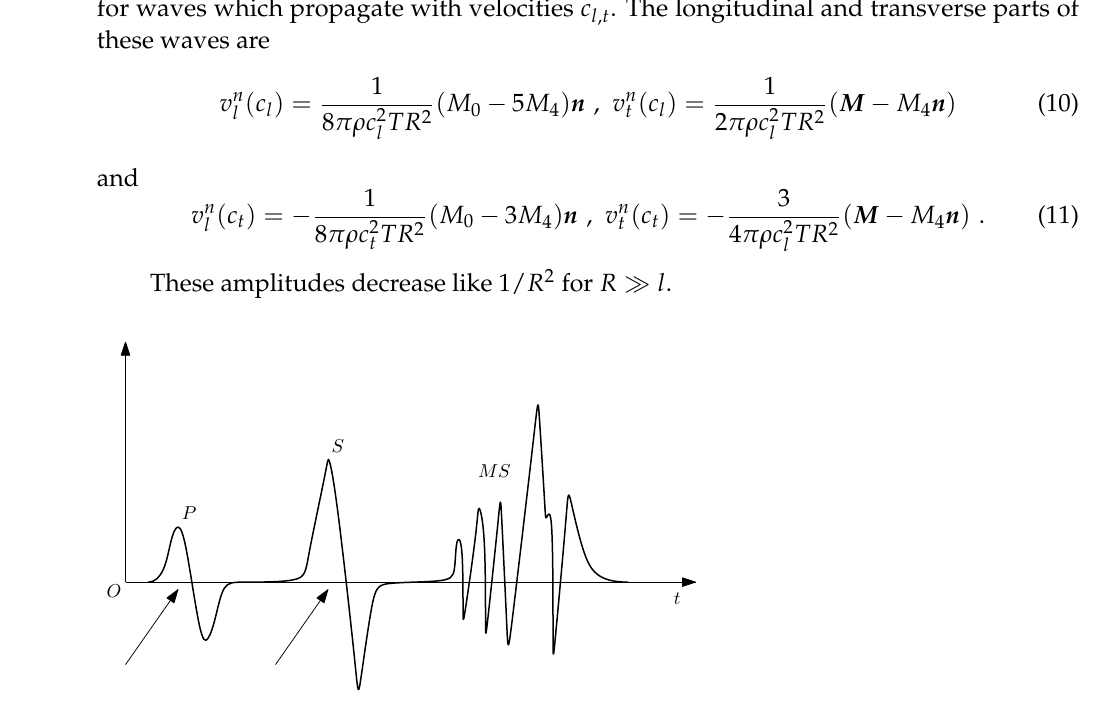
Figure 1. A qualitative sketch of scissor-like P and S seismic waves (indicated by arrows) and the seismic main shock ( MS ) , vs. time t .